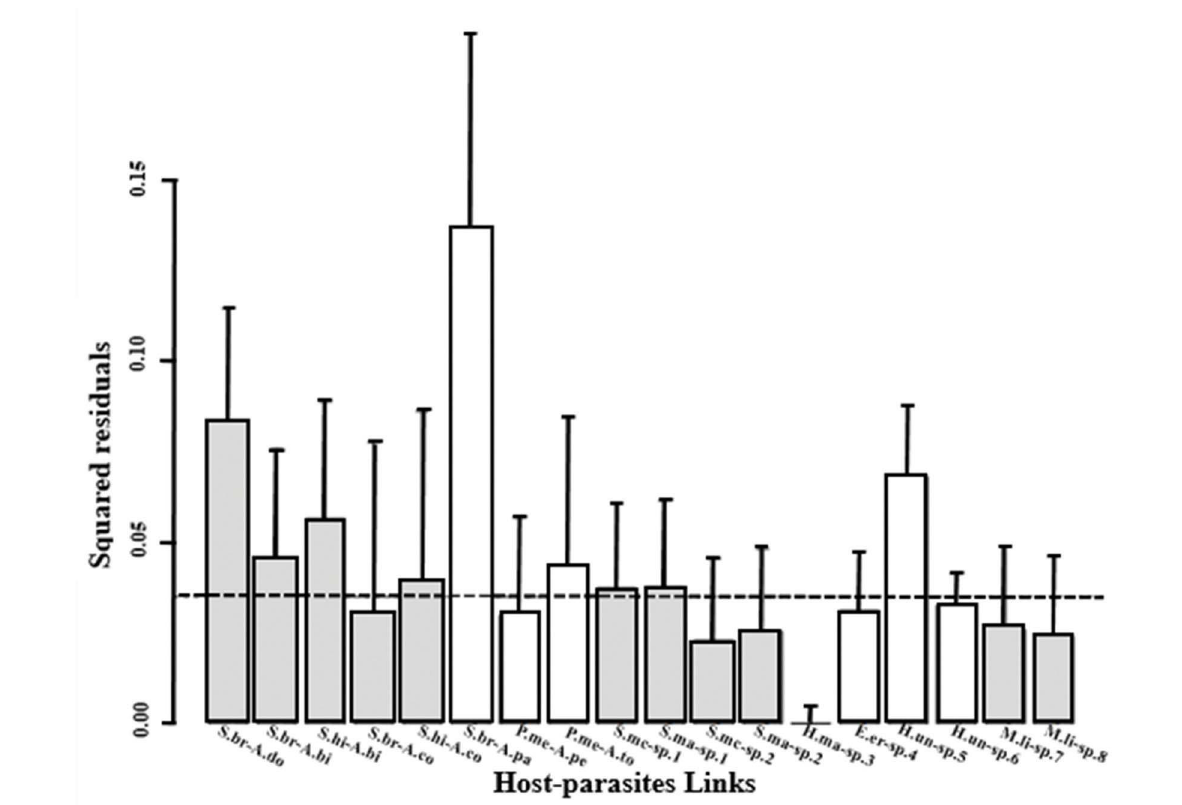
Fig 3. Contribution of individual associations to global phylogenetic congruence of Anacanthorus spp. and their hosts. The columns represent the squared residual of each association contributing to the total sum of squared residuals computed by PACo for patristic distances derived from the phylogenies shown in Fig 2).Error bars correspond to +95% confidence intervals. The mediansquared residual value is indicated by the stippled line. Host-parasite associations whose 95% squared residual confidence intervalfalls above the median value probably represent non-congruent associations. Grey bars represented significant coevolvinglinks according to ParaFitLink 1 and ParaFitLink 2 at α = 0.01. Abbreviations of Characiformes names: Bryconidae (S.hi = Salminus hilarii ; S.br = Salminus brasiliensis );Serrasalmidae (P.me = Piaractus mesopotamicus ;S.mc = Serrasalmus maculatus ;S.ma = Serrasalmusmarginatus ;M.li = Metynnis lippincottianus );Erythrinidae (H.ma = Hoplias malabaricus ;E.er = Erythrinus erythrinus ; H.un = Hoplerythrinus unitaeniatus ). Abbreviations of parasite names: A.bi = A . bicuspidatus ; A.co = A . contortus ; A.do = Anacanthorusdouradensis ;A.pa = Anacanthorus parakruidenieri ;A.sp. 1 = Anacanthorus sp. 1; A.sp. 2 = Anacanthorus sp. 2; A.pe = Anacanthoruspenilabiatus ;A.to = Anacanthorustoledoensis ;A.sp. 3 = Anacanthorus sp. 3; A.sp. 4 = Anacanthorus sp. 4; A.sp. 5 = Anacanthorus sp. 5; A.sp. 6 = Anacanthorus sp. 6; A.sp. 7 = Anacanthorus sp. 7; A.sp. 8 = Anacanthorus sp.